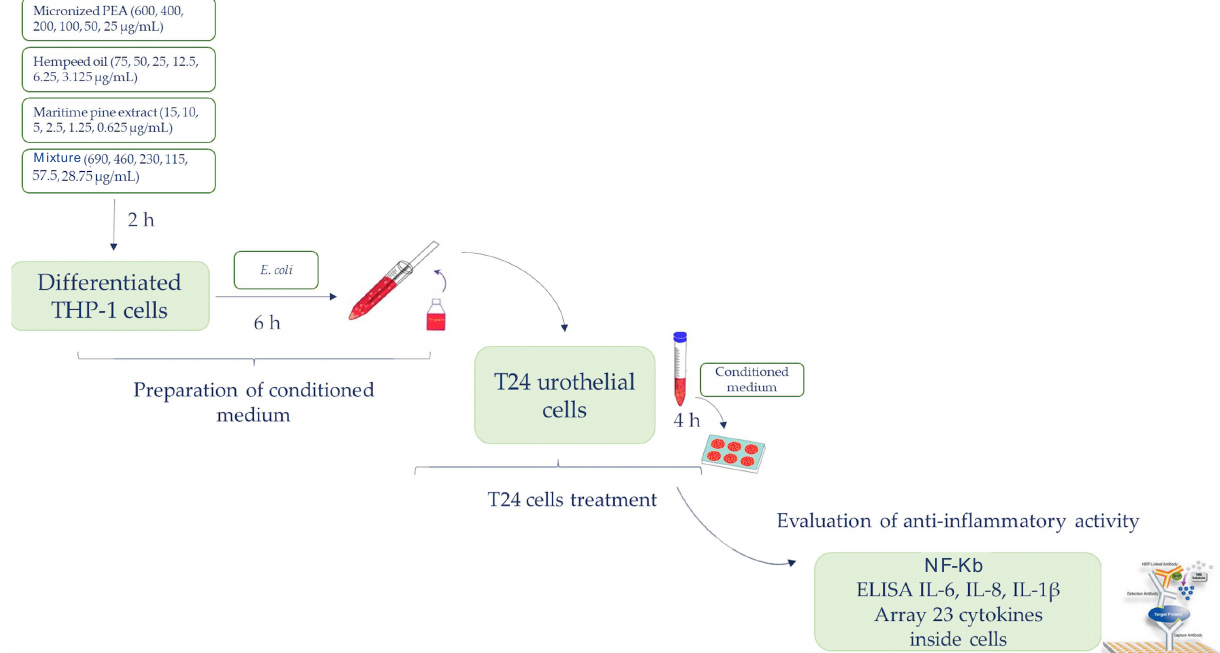
Figure 1. The flow chart illustrating the experimental approach.